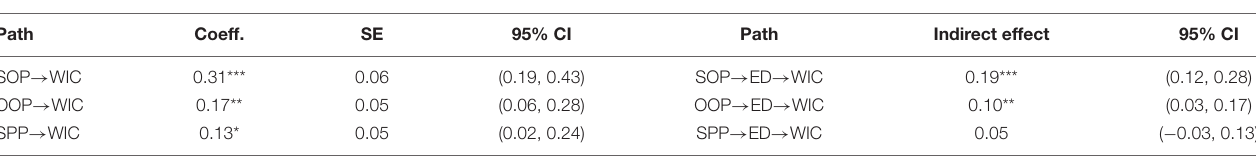
TABLE 3 | Bootstrapping results for unstandardized indirect effects from SEM. Path